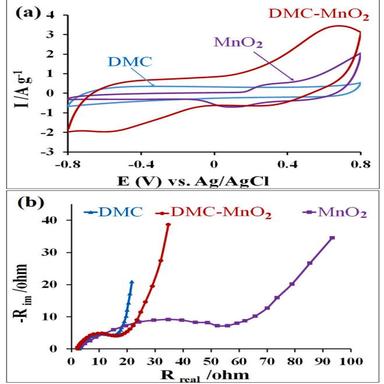
(a) CV curves and (b) Nyquist plots of DMC, MnO2 and DMC/MnO2 electrodes.